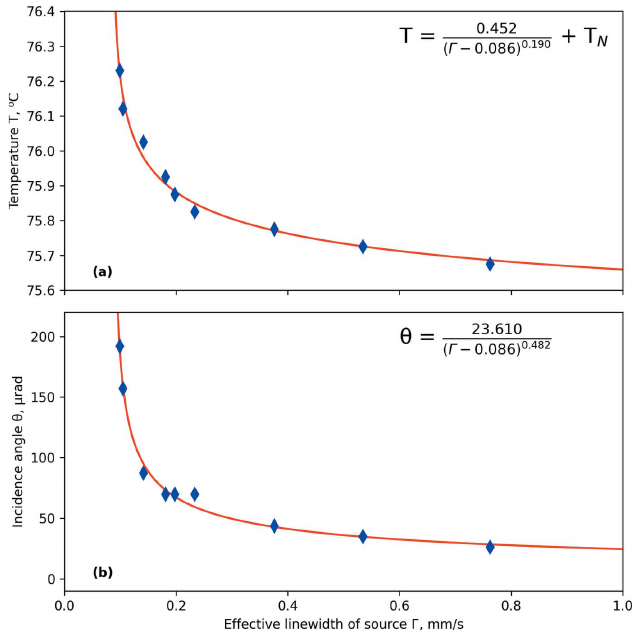
Figure 6 Selection of experimental data points closest to the envelope (blue dashed line in Fig. 5) for each studied temperature in the ( a ) width– temperature and ( b ) width–incidence angle representations. The red solid lines are the fits through the optimal points, shown by the equations at the top of each